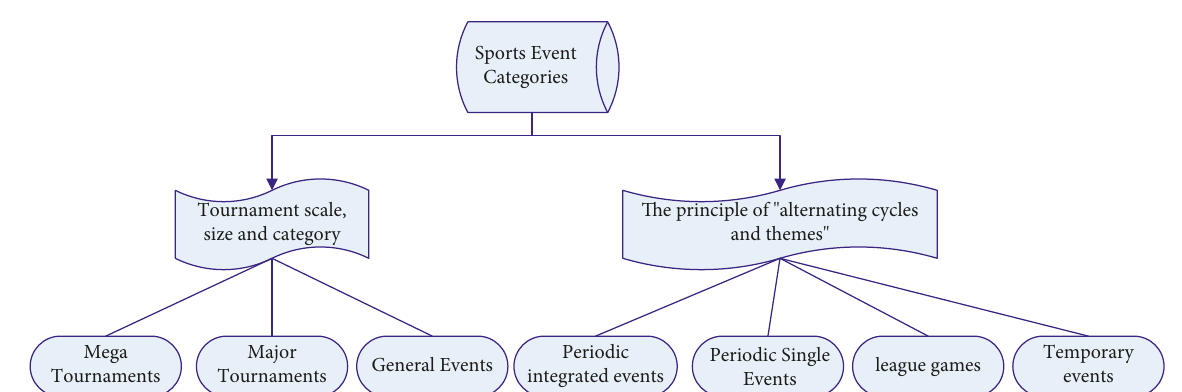
Figure 4: Classification of sporting